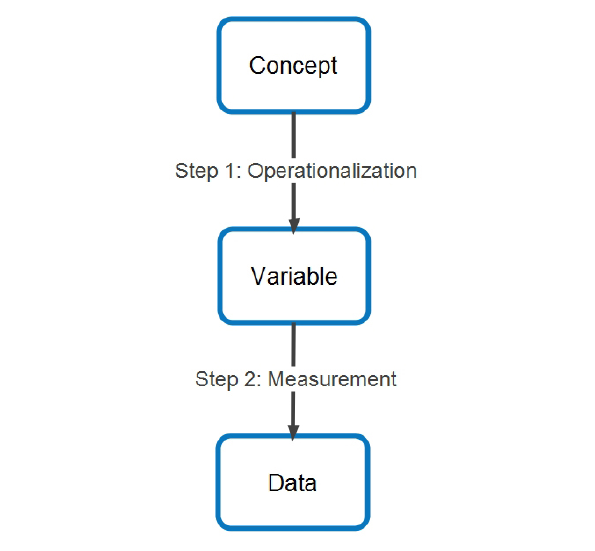
Fig. 1 . Measurement